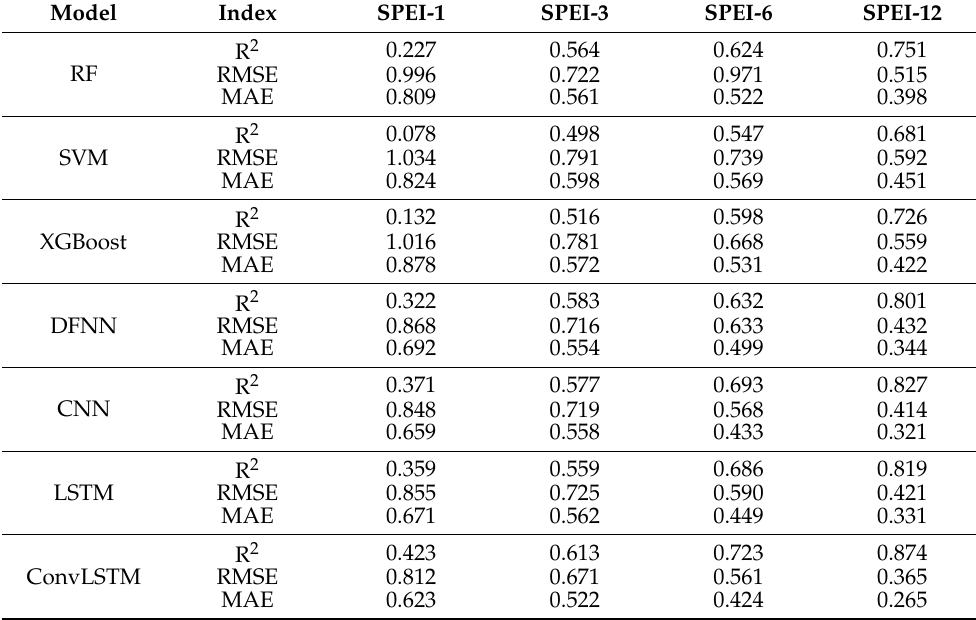
Table 6. Monitoring performance metrics for the seven models on the test